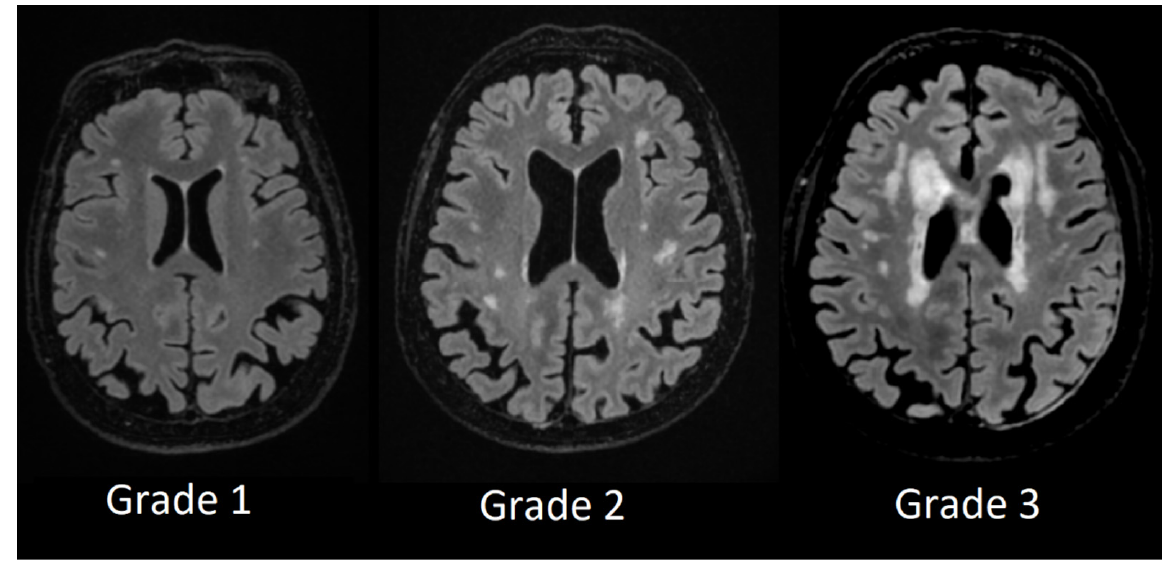
Figure 4. Deep white matter hyperintensities based on Fazekas scale from Grade 1 to Grade 3.